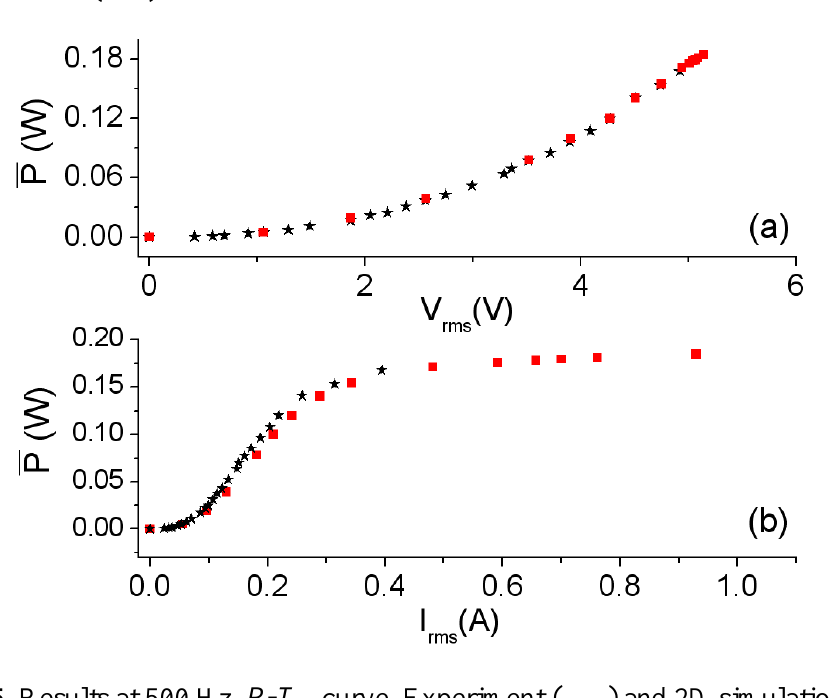
Figure 5. Results at 500 Hz. R - I